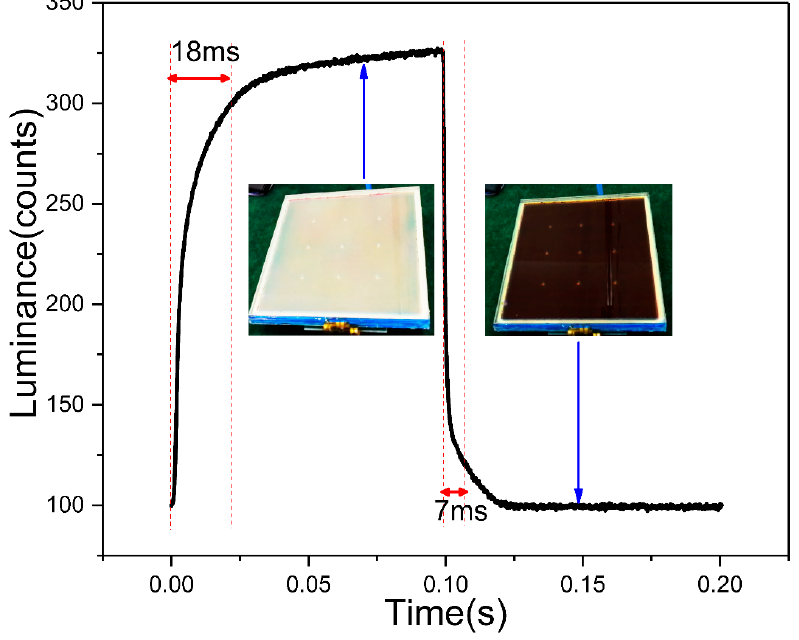
Figure 7. The optical response measured by colorimeter of the EWDs.